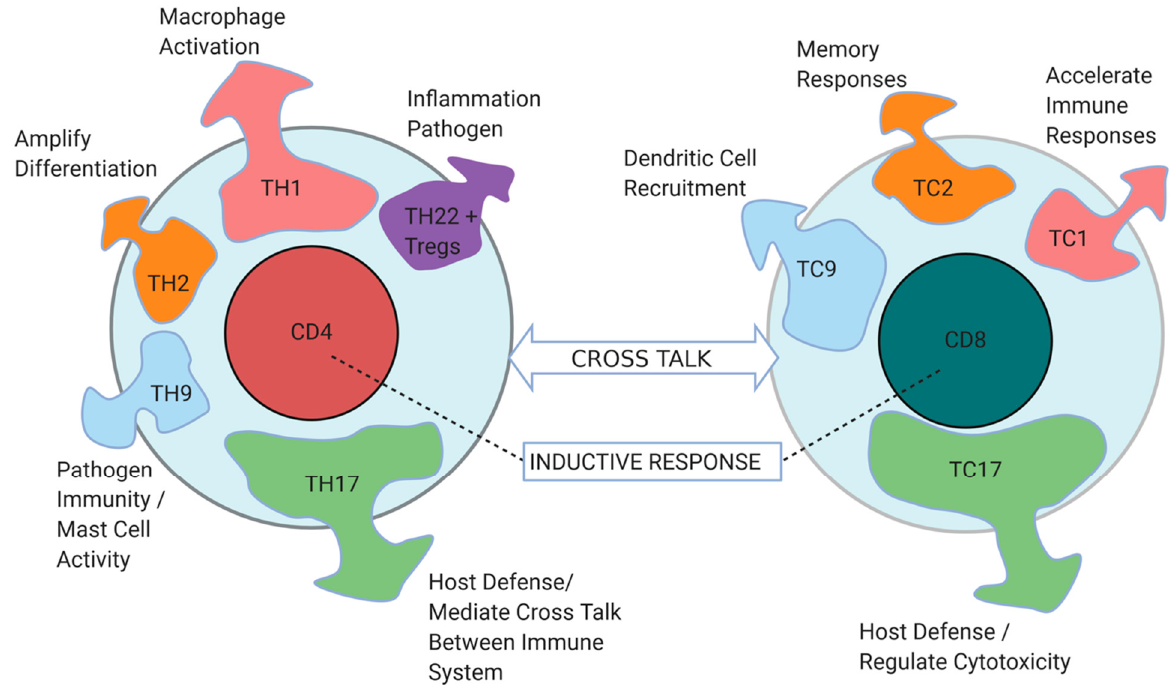
Figure 2. CD4 + and CD8 + T cell identity and functions are regulated by a palette of cytokines. CD4 + and CD8 + T cells interact within the tumor microenvironment and secrete different sets of cytokines, which control several and distinct immune responses, represented by different colors in the diagram. Cytokines secreted by each T cell type are as follows: IFN- γ , IL-2, TNF- α , and TNF- β by TH1, IL-4 and IL-10 by Th2, IL-9 by TH9, IL-17, IL-17F, IL-21, and IL-22 by Th17, IFN- γ and TNF- α by TC1, IL-4 and IL-12 byTC2, IL-9 by TC9, and IL-17A, IFN- γ , TNF- α , IL-21, and IL-22 by TC17. Arrow thickness and size represent the magnitude of influence that a specific subset of cytokines have on the tumor microenvironment immune responses. CD8 + T cell functions are regulated by CD4 + T cells and the cross talk between the two cell types is critical for establishing an effective anti-tumor immunity and microenvironment. Figure created with BioRender.com.